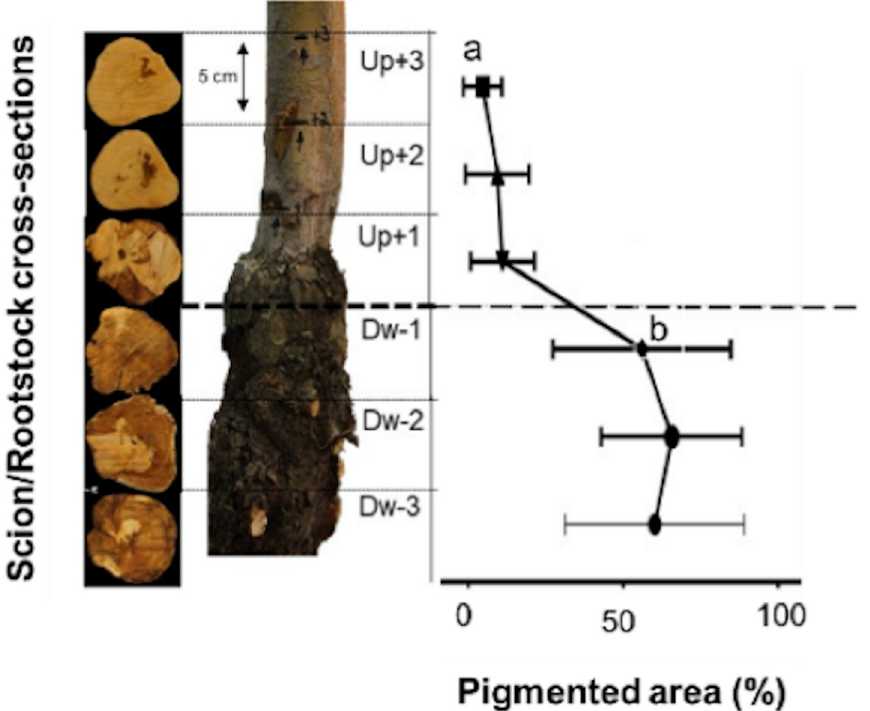
Fig 4. Scion and rootstock cross sections from ‘HoneyCrisp’ apple trees grafted onto M.9 (clone NIC 29) with rapid apple decline. Three cuts of 5 cm were made above and below the graft union at the scion-rootstock junction. The following discoloration scale was used to estimate healthy and pigmented necrotic wood area in symptomatic apple trees: DS = 1, external wood discoloration, DS = 2, internal wood discoloration, DS = 3, co-occurrence of external and internal wood discoloration, DS = 4, edge-shaped discoloration ( < 50%), DS = 5, edge-shaped discoloration ( > 50%), and DS = 6, circular discoloration.